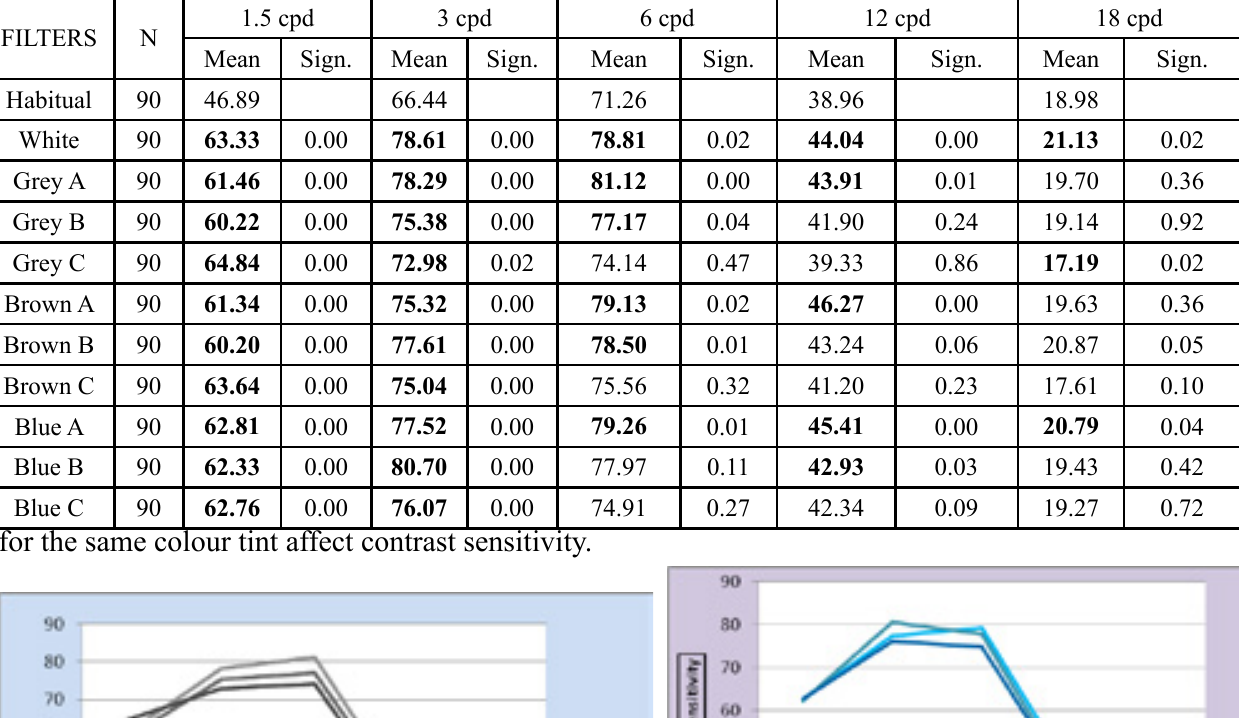
Table 2: Mean contrast sensitivity scores for various spatial frequencies and the significance values when compared to habitual condi - tions